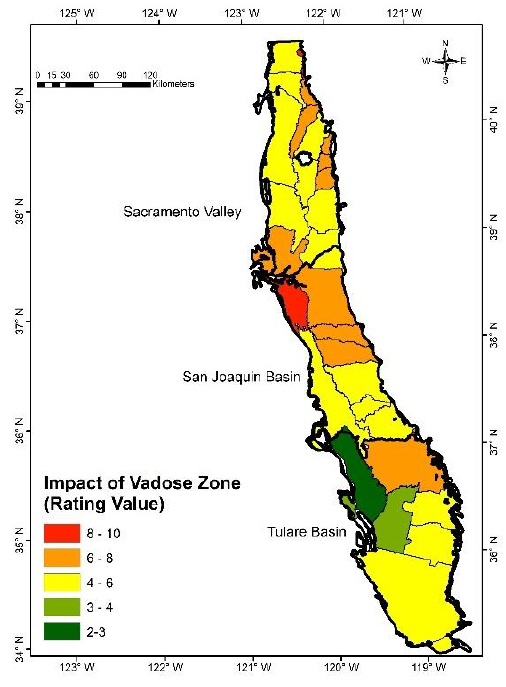
Figure 9. Impact of Vadose Zone in Central